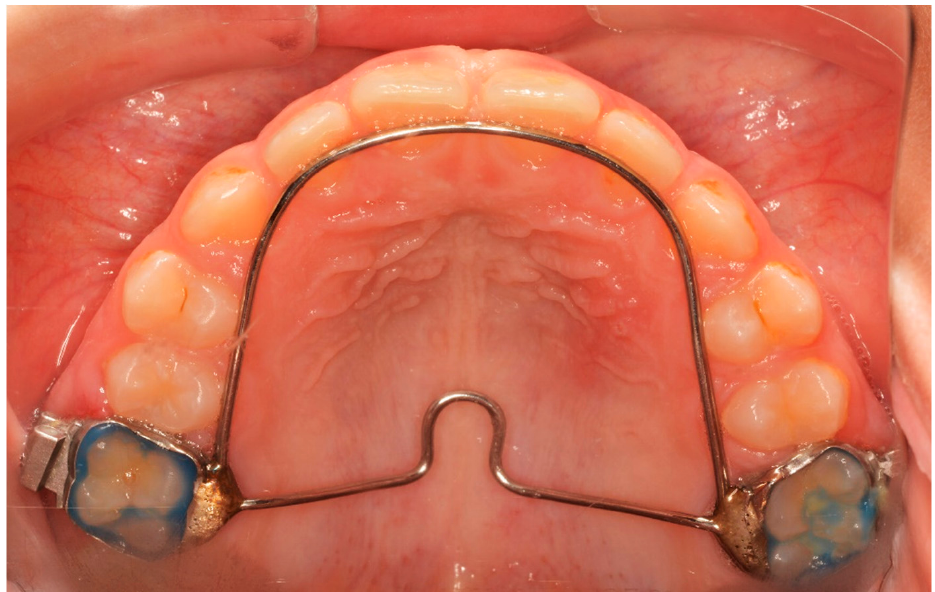
Figure 2. Horse-shoe-type TPA used after T2 time interval.